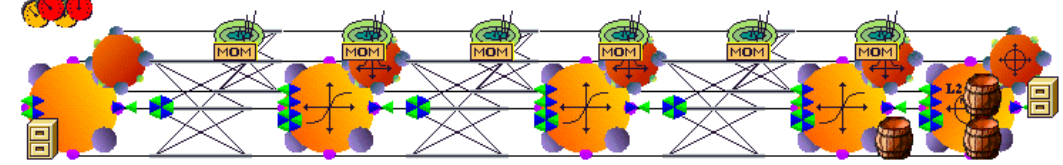
Figure 5. NeuroSolutions Multi-Layer Perceptron Supervised Neural